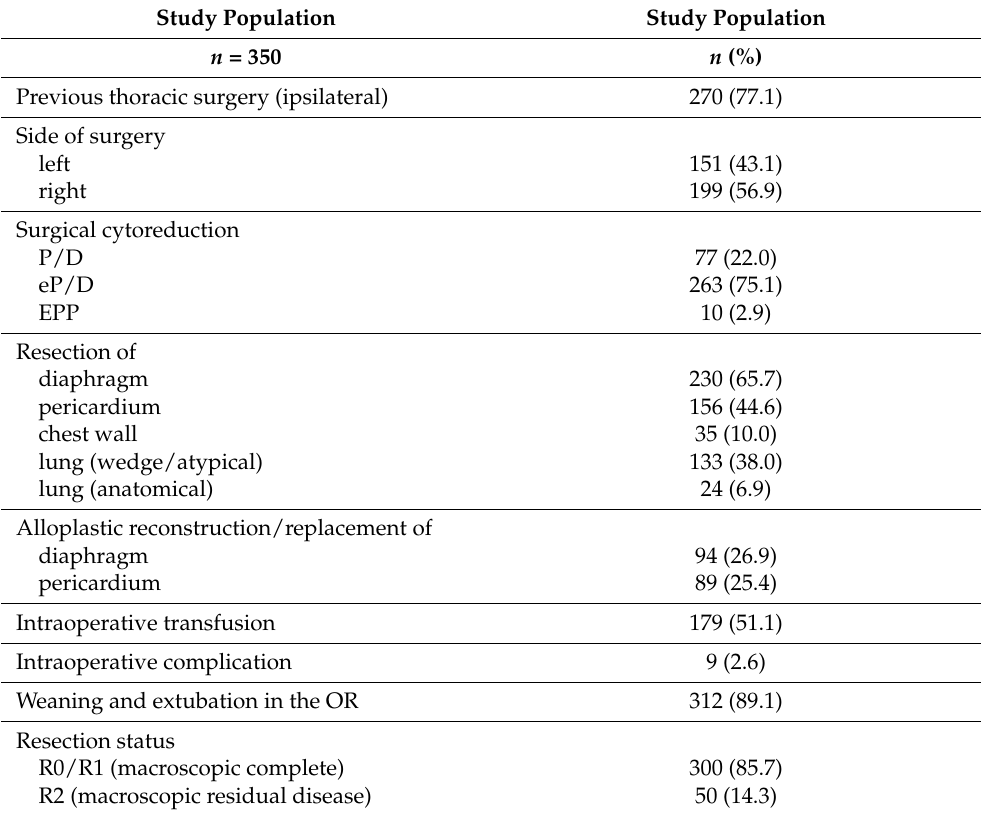
Table 2. Intraoperative data of